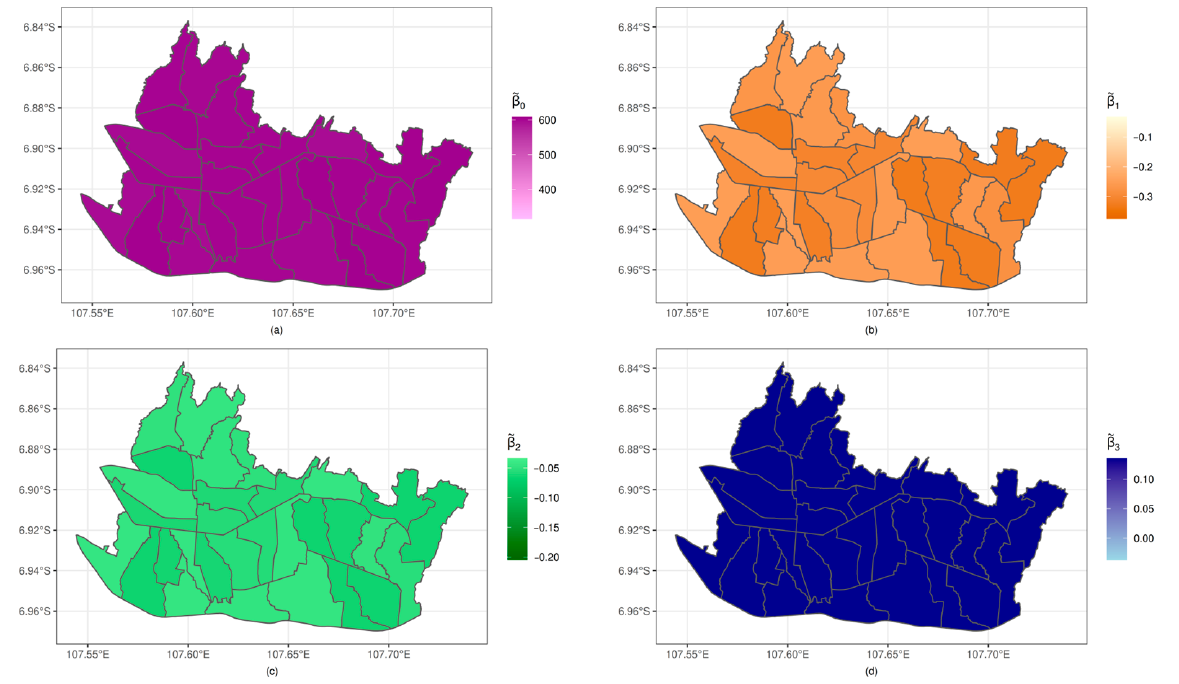
Figure 6. Coefficient maps of space variable for quantile 0.75 of dengue fever in Bandung city from 2017–2021 (( a ) for intercept, ( b ) for slope 1, ( c ) for slope 2, and ( d ) for slope 3).